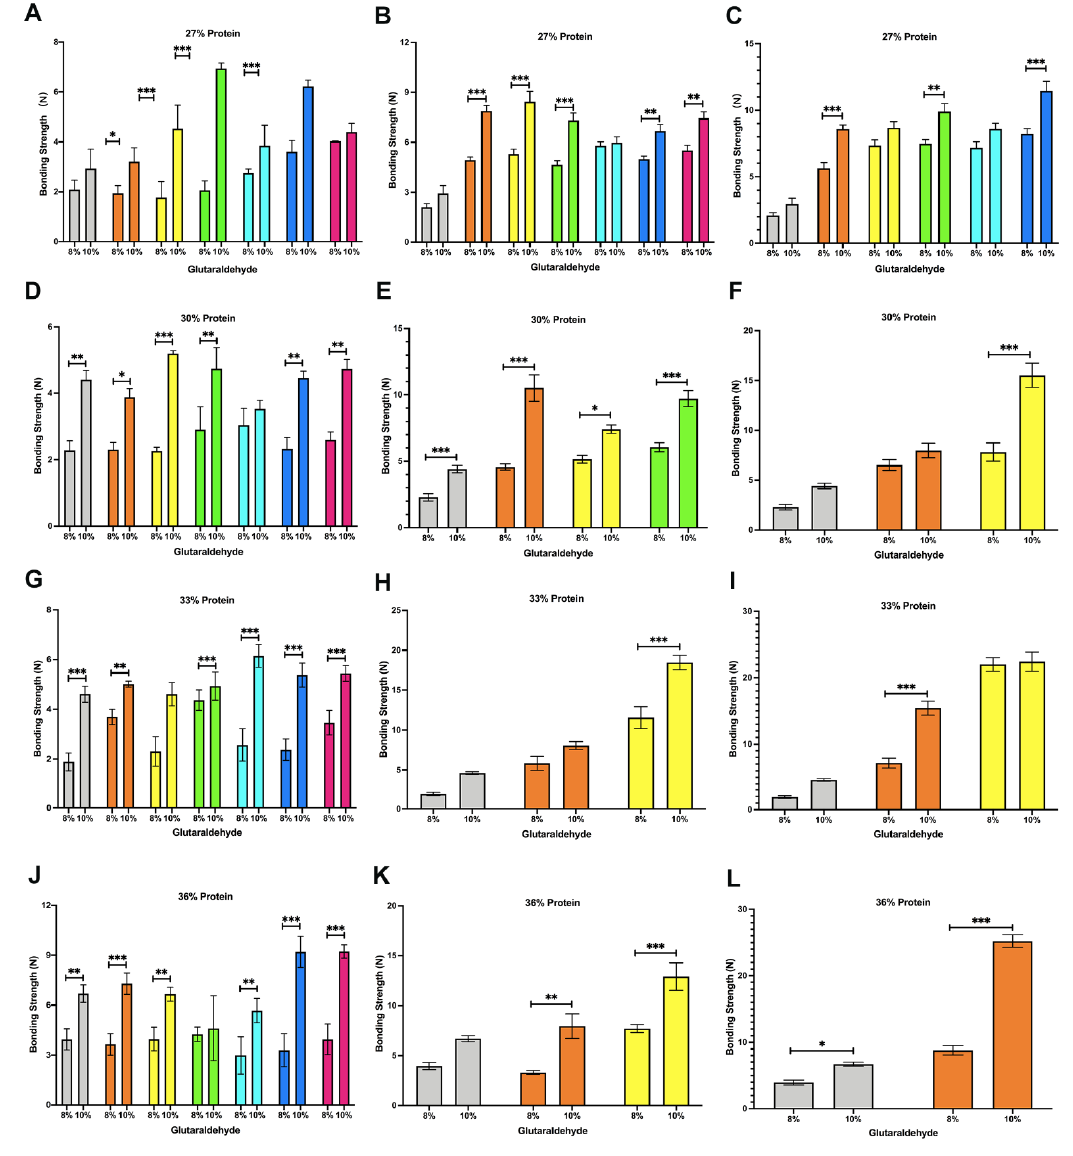
Figure 6. Relationship between irradiation intensity, storage time, and cross-linker and WPI solution concentrations. ( A – C ) The bonding strength of 27% WPI solution and GTA (8% and 10%) with different irradiation dosages after the first, third, and the fifth month of gamma radiation, respectively. 25 kGy gamma irradiated WPI formed gelation in the during period. Bonding strength cannot be conducted. ( D – F ) The bonding strength of 30% WPI solution and GTA (8% and 10%) with different irradiation dosages after the first, third, and the fifth month of gamma radiation, respectively. High-dosage irradiated WPI solutions formed gelation in last two periods. ( G – I ) The bonding strength of 30% WPI solution and GTA (8% and 10%) with different irradiation dosages after the first, third, and the fifth month of gamma radiation, respectively. 15–25 kGy irradiated WPI solutions cannot be used in bonding strength in last two periods. ( J ) The bonding strength of 36% WPI solution and GTA (8% and 10%) with different irradiation dosages after the first month of gamma radiation. ( K ) The bonding strength of 36% WPI solution and GTA (8% and 10%) with different irradiation dosages after the third month of gamma radiation. ( L ) The bonding strength of 36% WPI solution and GTA (8% and 10%) with different irradiation dosages in the fifth month of gamma radiation. Only 10 kGy irradiated WPI solutions can be used in last test (* p < 0.5; ** p < 0.1; *** p <